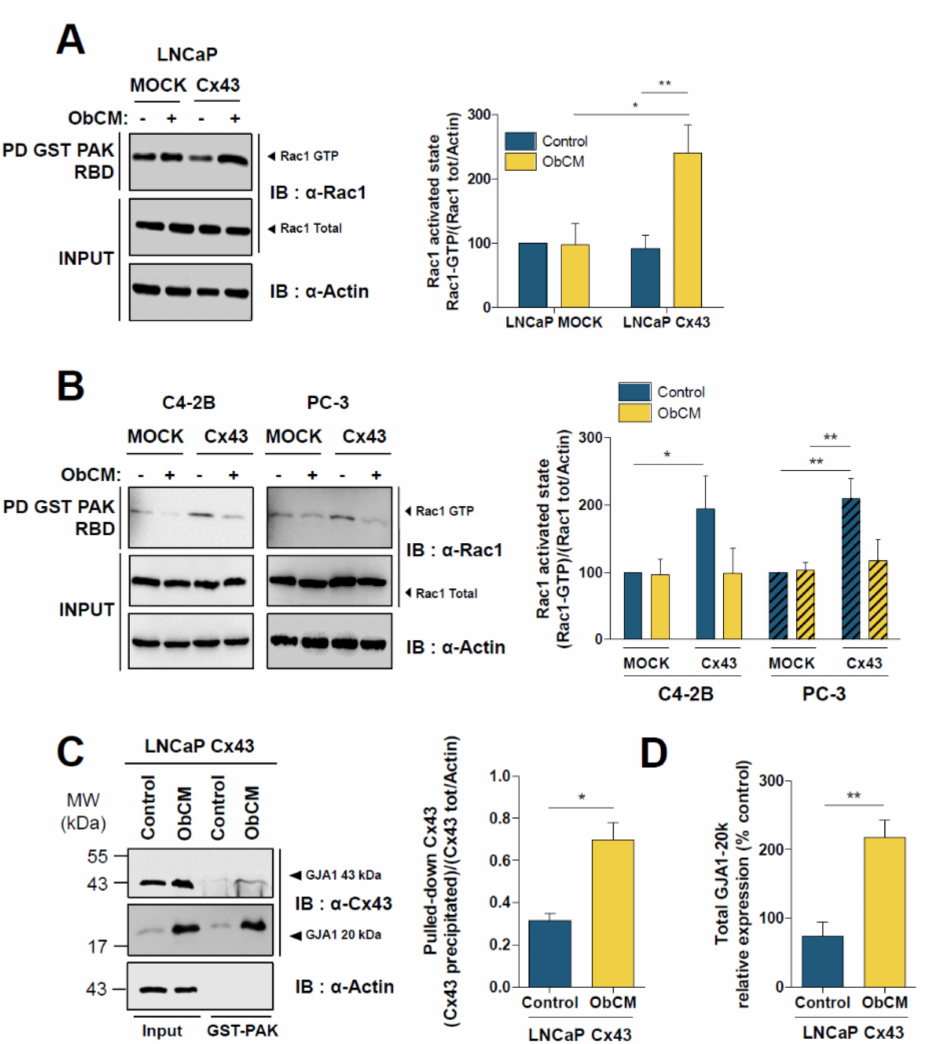
Figure 9. ObCM-induced migration of Cx43 targeting plasma membrane relies on Rac1 pathway. ( A ) Representative immunoblot and densitometric quantification of Rac1 (total and activated pool) as determined by GST pull down in LNCaP cells after 17 h of stimulation with or without ObCM. Celllysateswereincubatedwithsepharose-boundGST-fusedPAK-RBDandeithertotalcelllysate(input) or pulled-down bead-bound complexes comprising activated form of Rac1 (GTP-bound, Pulldown GST-PAK-RBD) were immunoblotted with anti-Rac1 antibody. Data represent the mean ± SEM from 4 di ff erent experiments. ( B ) Rac1 activated state was assessed as described in ( A ) in PC-3 and C4-2B overexpressing Cx43. Data represent the mean ± SEM from 4 di ff erent experiments. ( C ) representative immunoblot and densitometric quantification of Cx43 (total and PAK-RBD-interacting pool) as determined by GST pull down in LNCaP cells after stimulation with or without ObCM. Cells were treated as in ( A ), but immunoblotting was done with anti-Cx43 antibody. Actin served as control, showing no binding to GST-PAK-RBD. ( D ) densitometric quantification of GJA1-20k in LNCaP Cx43 after ObCM stimulation. Data represent the mean ± SEM from 4 di ff erent experiments. * p < 0.05; ** p <